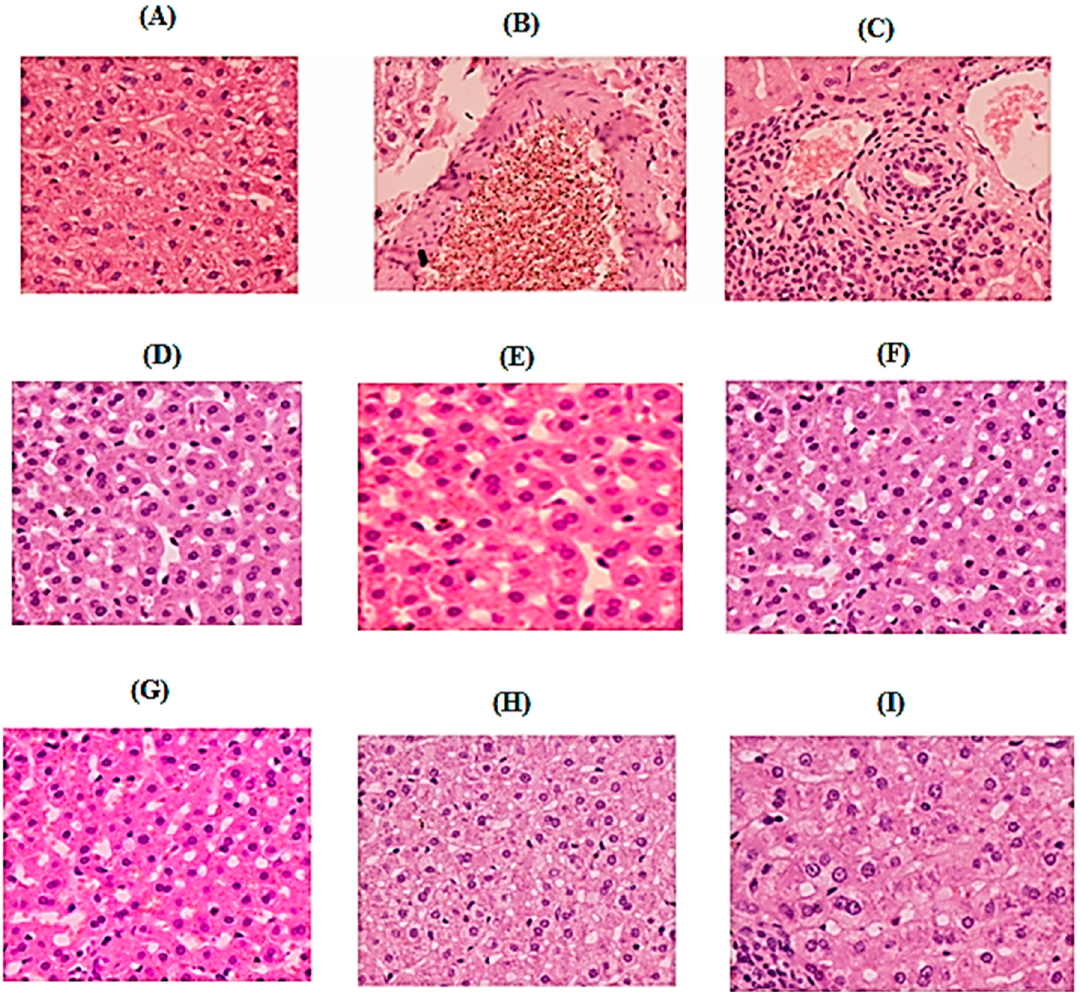
Figure 6. Effects of catechin (2, 5, 10, 15, 30 and 50 mg/kg) and glibenclamide (5 mg/kg) on pancreas histopathology studies in STZ-induced diabetic rats (H&E staining; 40 × , scale bar = 100 µ m): ( A ) control group; ( B ) diabetic control group; ( C ) glibenclamide (5 mg/kg/overly) treated group; ( D , E ) CTN (2, 5 mg/kg/orally) treated group; ( F , G ) CTN (10, 15 mg/kg/orally) treated groups ( H , I ) CTN (30 and 50 mg/kg/orally) treated group.